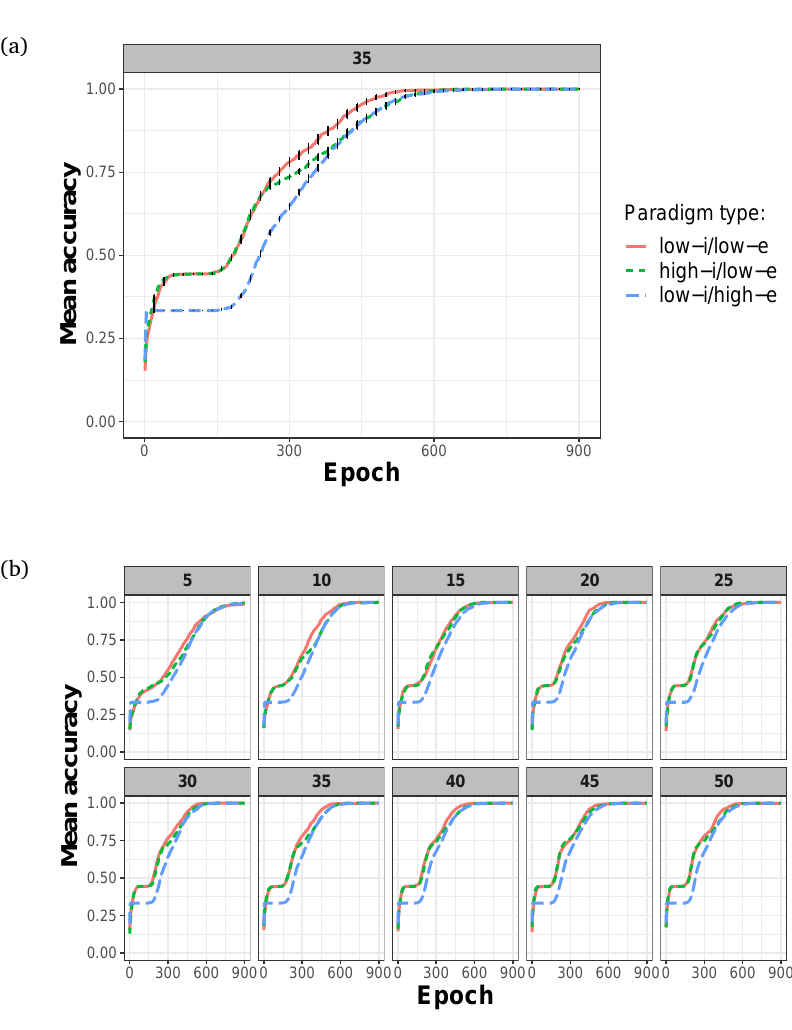
Figure 2: Network learning trajectories. (a) results for one network size (35 cells), with error bars indicating standard error every 10 epochs, (b) results for all net- work sizes tested (facet titles give network size in number of cells). Networks trained on low-i/low-e and high-i/low-e paradigm types show similar learning trajectories, while networks trained on low-i/high-e paradigms show lower ac- curacy levels. Results from models with further learning rates for both SGD and Adam optimizers show similar patterns for most cases, and we never see the op- posite trend of lower accuracies for the high-i/low-e condition (see the Appendix for detailed